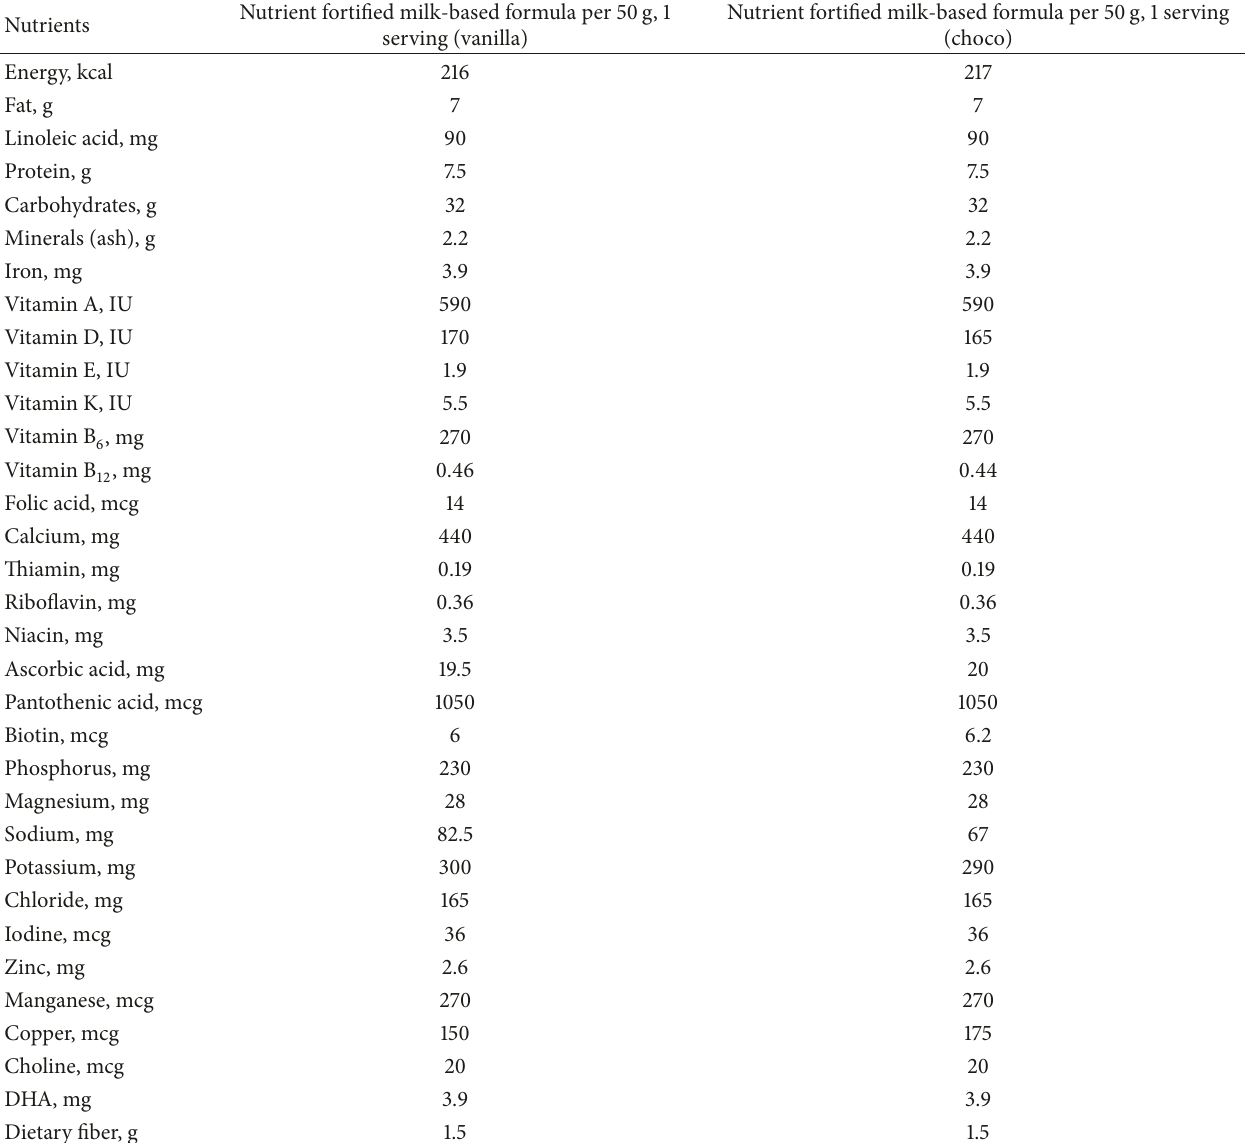
Table 1: Nutrient content of test food (nutrient fortified milk based